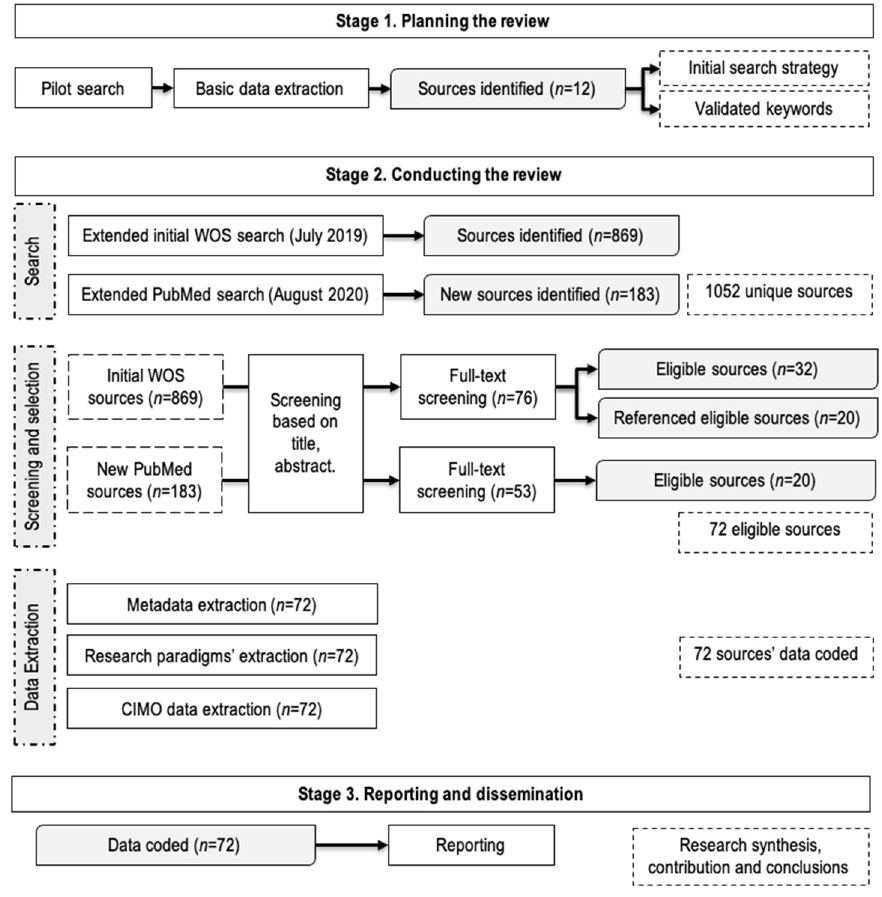
Figure 1. Research process.